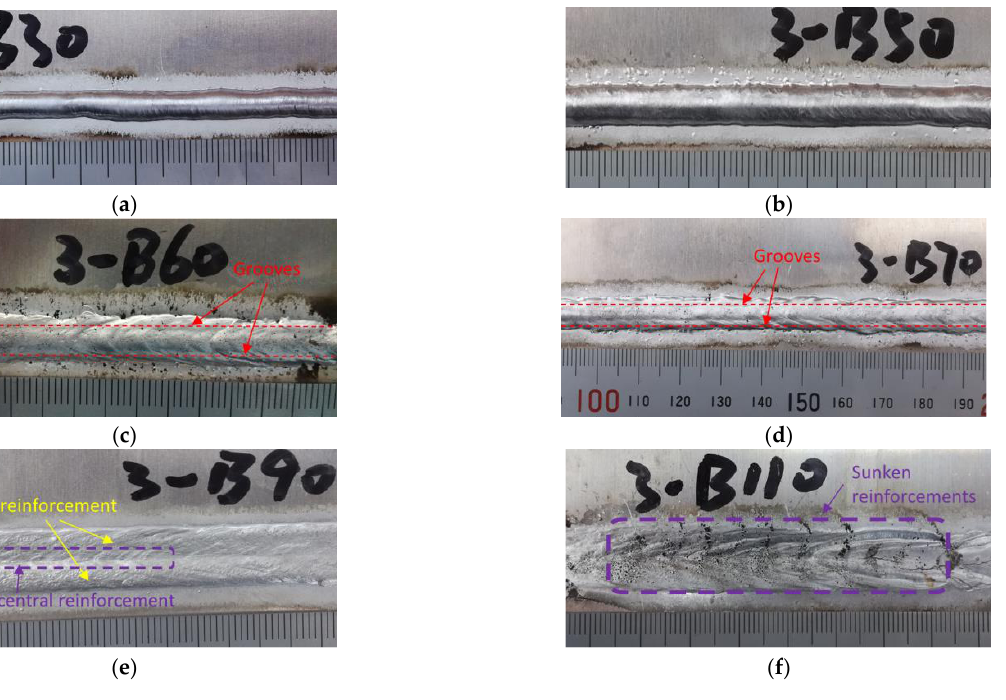
Figure 3. The profile shape of a bead with the increase in heat input. ( a ) Inverted “U” shape; ( b ) Inverted “U” shape; ( c ) “ W ” shape; ( d ) “ W ” shape; ( e ) “V” shape; ( f ) “ U ” shape.